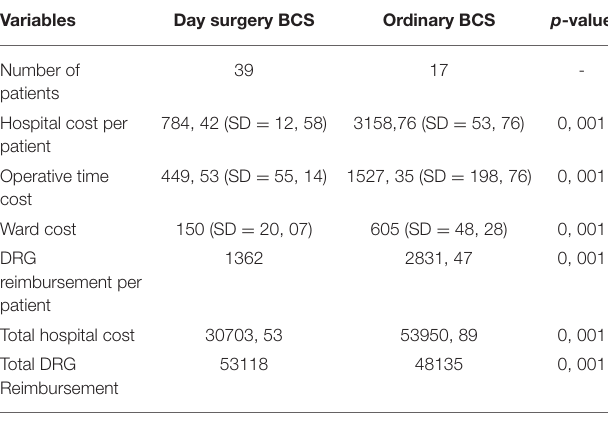
TABLE 3 | Composite cost evaluation.